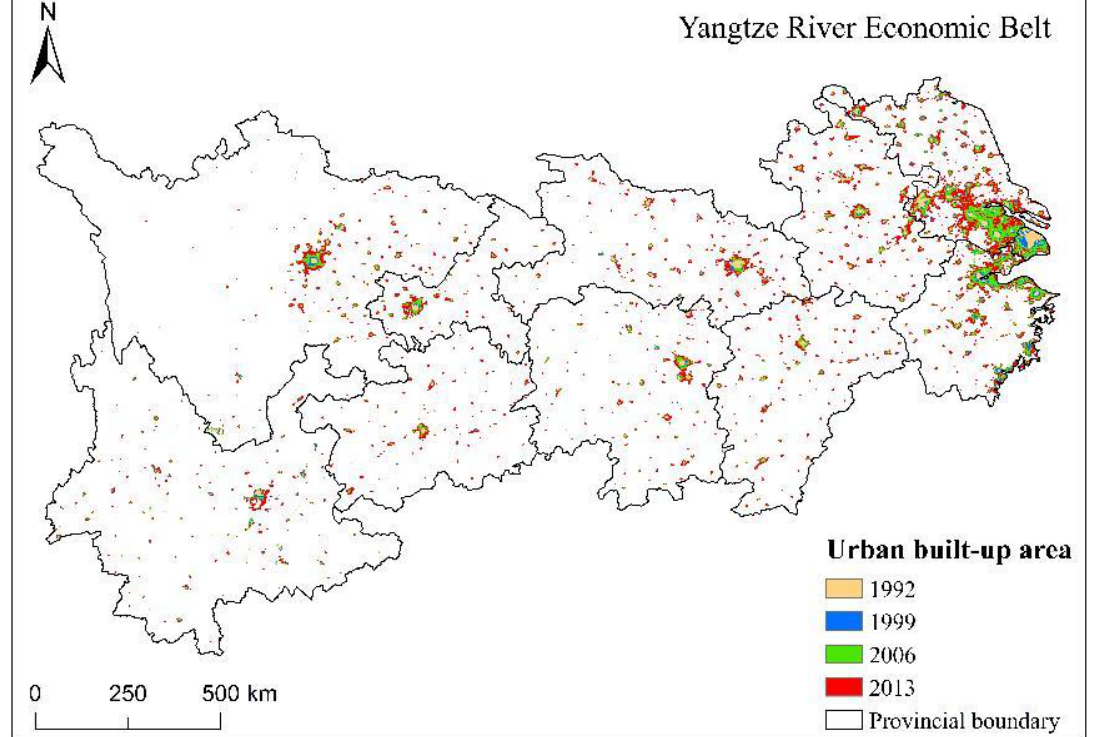
Figure 2. A map of four years (1992, 1999, 2006, and 2013) of evolution of the urban built-up area in the YREB